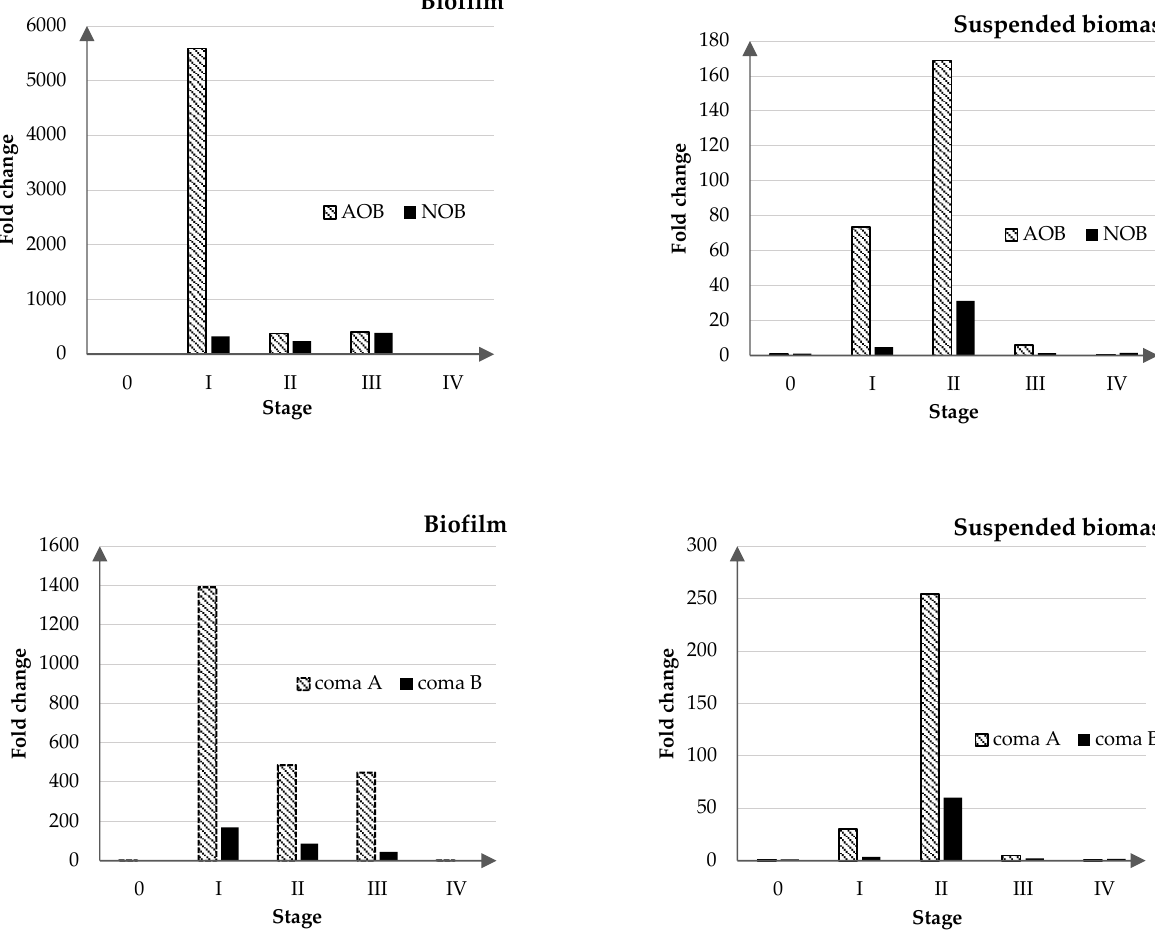
Figure 4. Relative qPCR analysis of bacterial population changes in IFAS-MBSBBR. The results show the values of fold changes for biofilm and activated sludge at four stages of the process (I–IV) in relation to biomass at the beginning of the process (0). AOB—ammonia-oxidizing bacteria, NOB—nitrite-oxidizing bacteria, coma A—lineage A of Comammox bacteria, coma B—lineage B of Co-